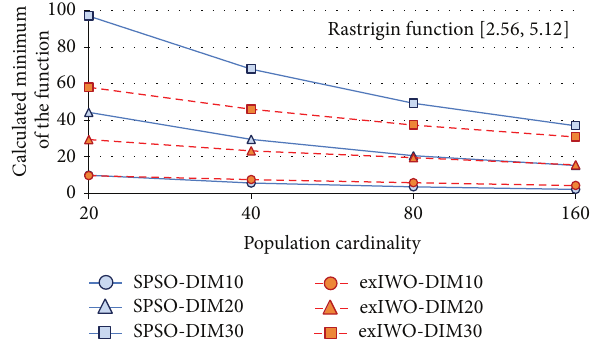
Figure 14: Comparison between SPSO and exIWO based on the Rastrigin